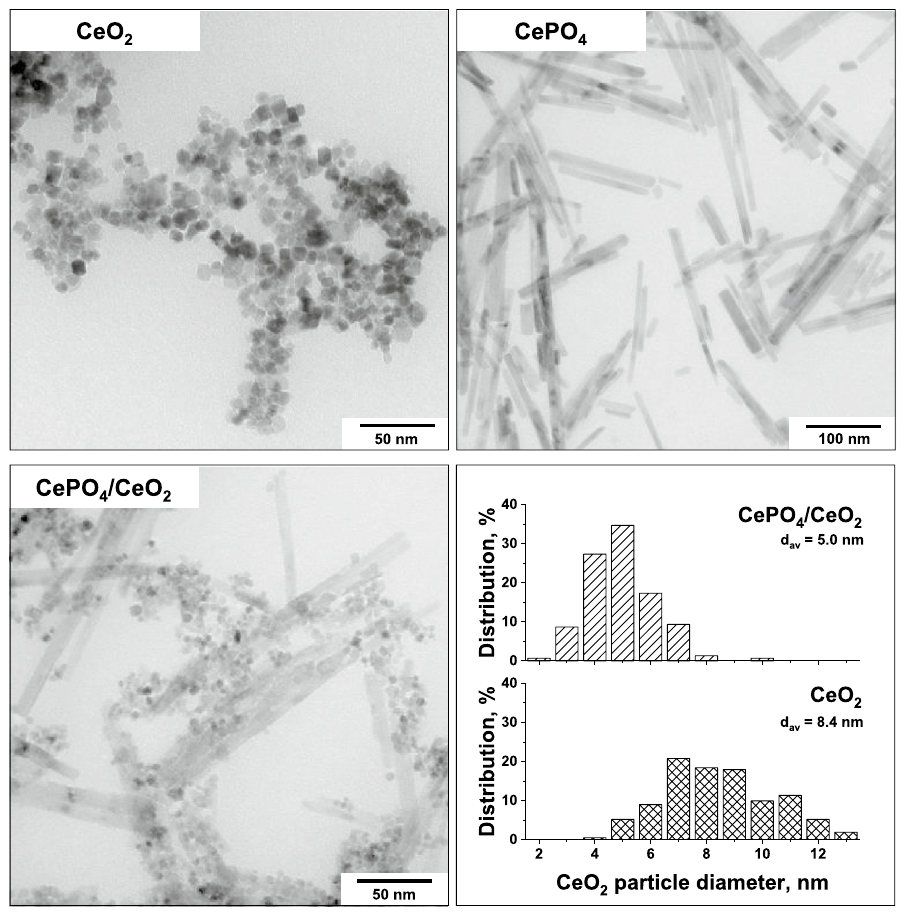
Figure 4. TEM images of the catalysts and ceria particle size distribution estimated for CeO 2 and CePO 4 /CeO 2